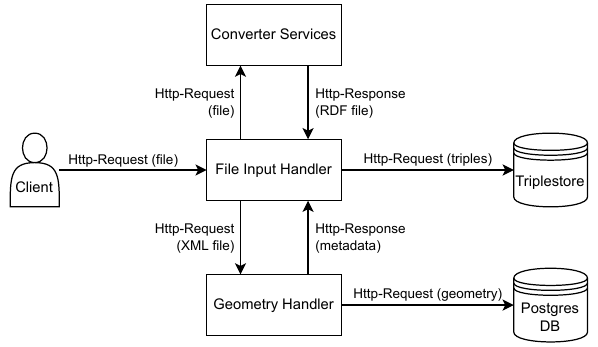
Figure 3. Communication between microservices while data